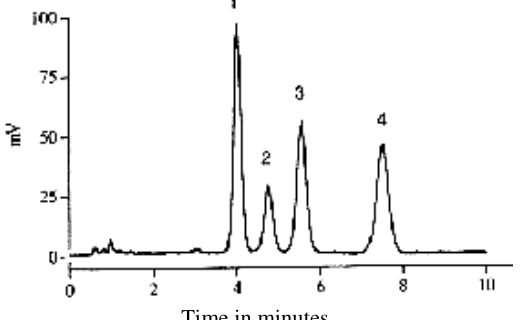
Figure 1 . A typical chromatogram of a mixture of